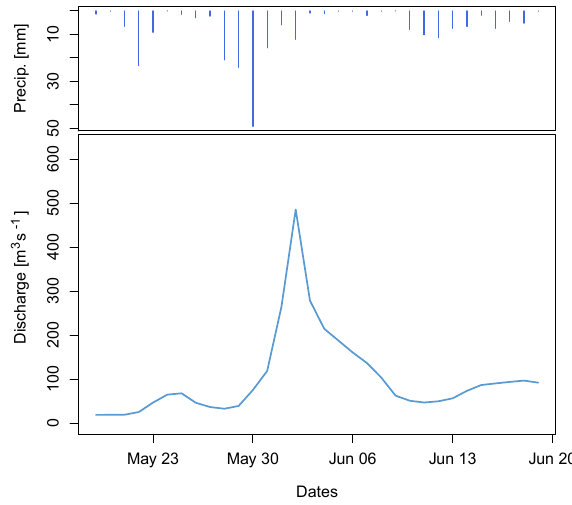
Figure 7. Daily hydrograph of the River Loing at Épisy (3900km 2 ) during the event of June 2016. Overall precipitation reached 130mm. The peak discharge was the largest ever observed on the catchment and reached about 500m 3 s − 1